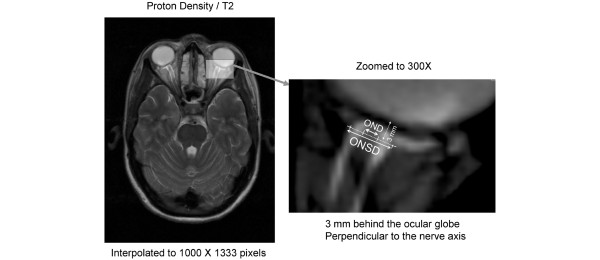
Methodology to measure ONSD and OND. OND, optic nerve diameter; ONSD, optic nerve sheath diameter.